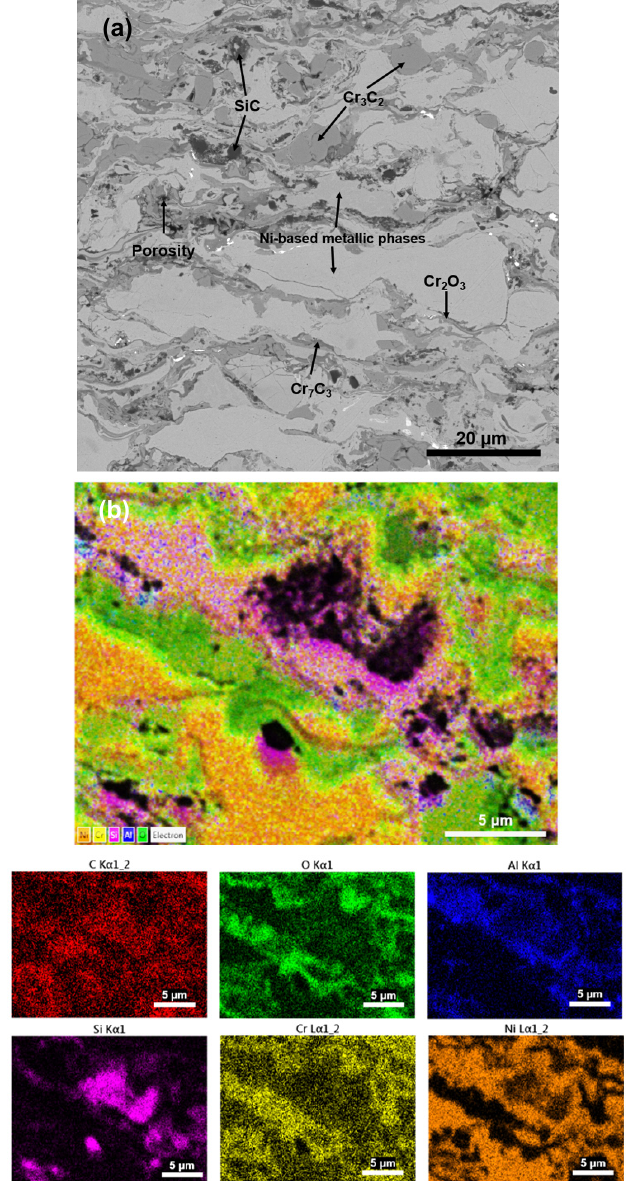
Figure 6. SiC-NiCrAlY/Cr 3 C 2 -NiCr coating ( a ) microstructure and ( b ) EDS analysis.